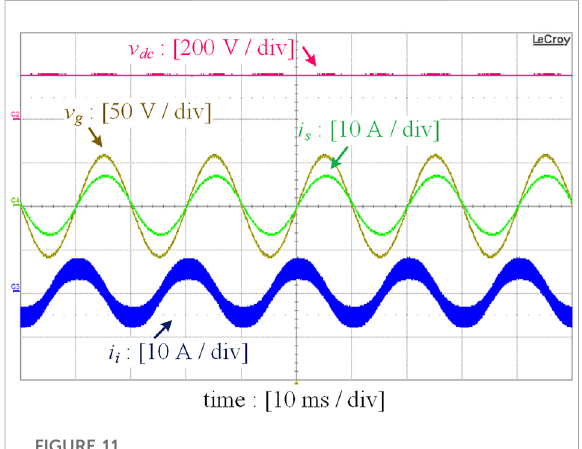
FIGURE 11 Experimental waveforms with reactive power compensated by the conventional LCL - fi ltered half-bridge DSTATCOM.